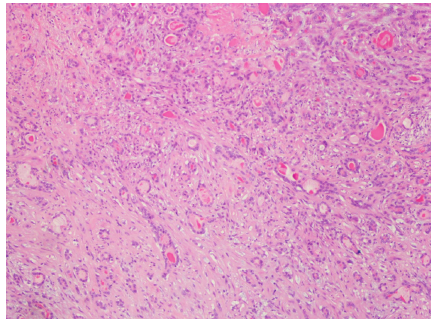
Figure 3: Tumor, duct-like structures and spindle areas (hema- toxylin eosin, original magnification × 100).